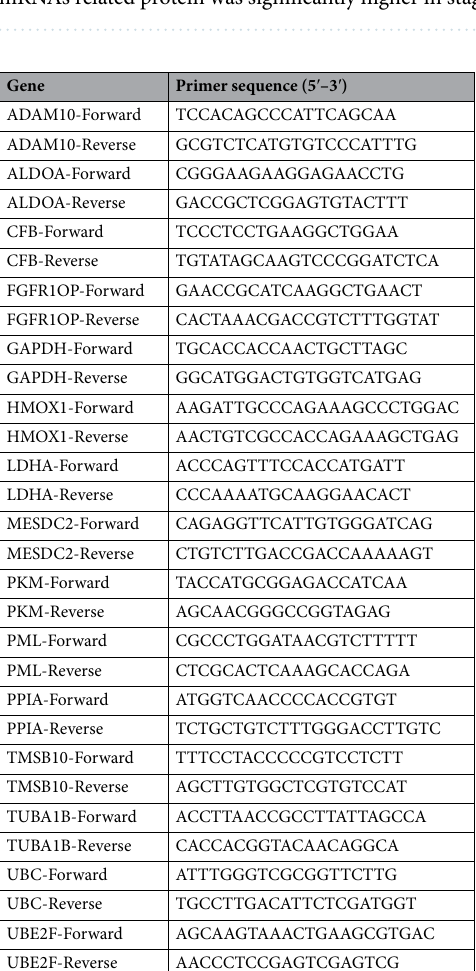
Figure 13. The expression of 15 mRNAs related protein in tumor tissue detected by Westernblot. These 15 mRNAs related protein was significantly higher in stage II NSCLC than in stage I ( P < 0.05).